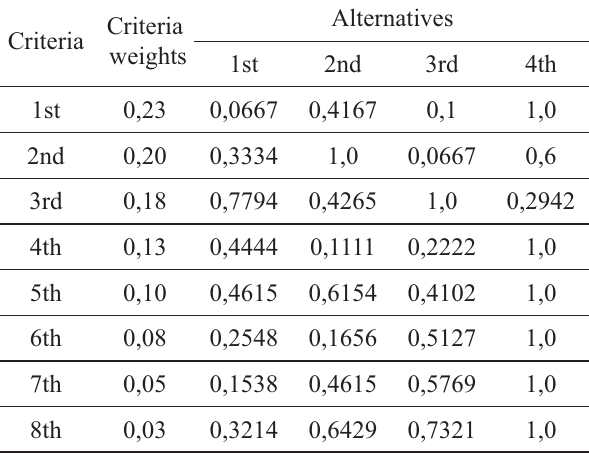
Table 5. Non-dimensional values of the considered